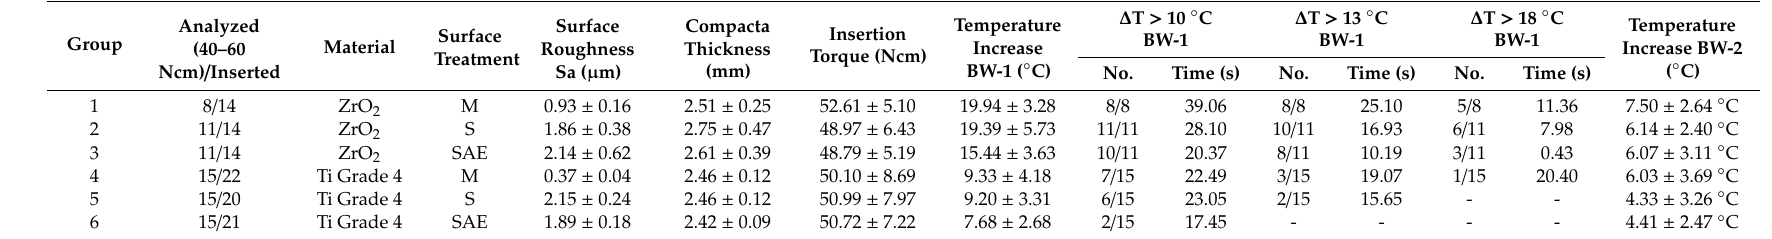
Table 1. Temperature increase of the 6